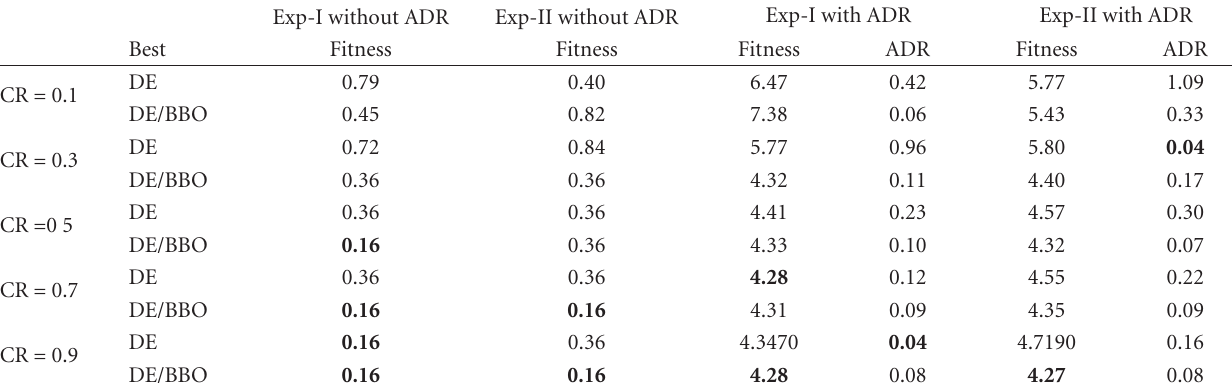
Table 6: E ff ect of the parameter of